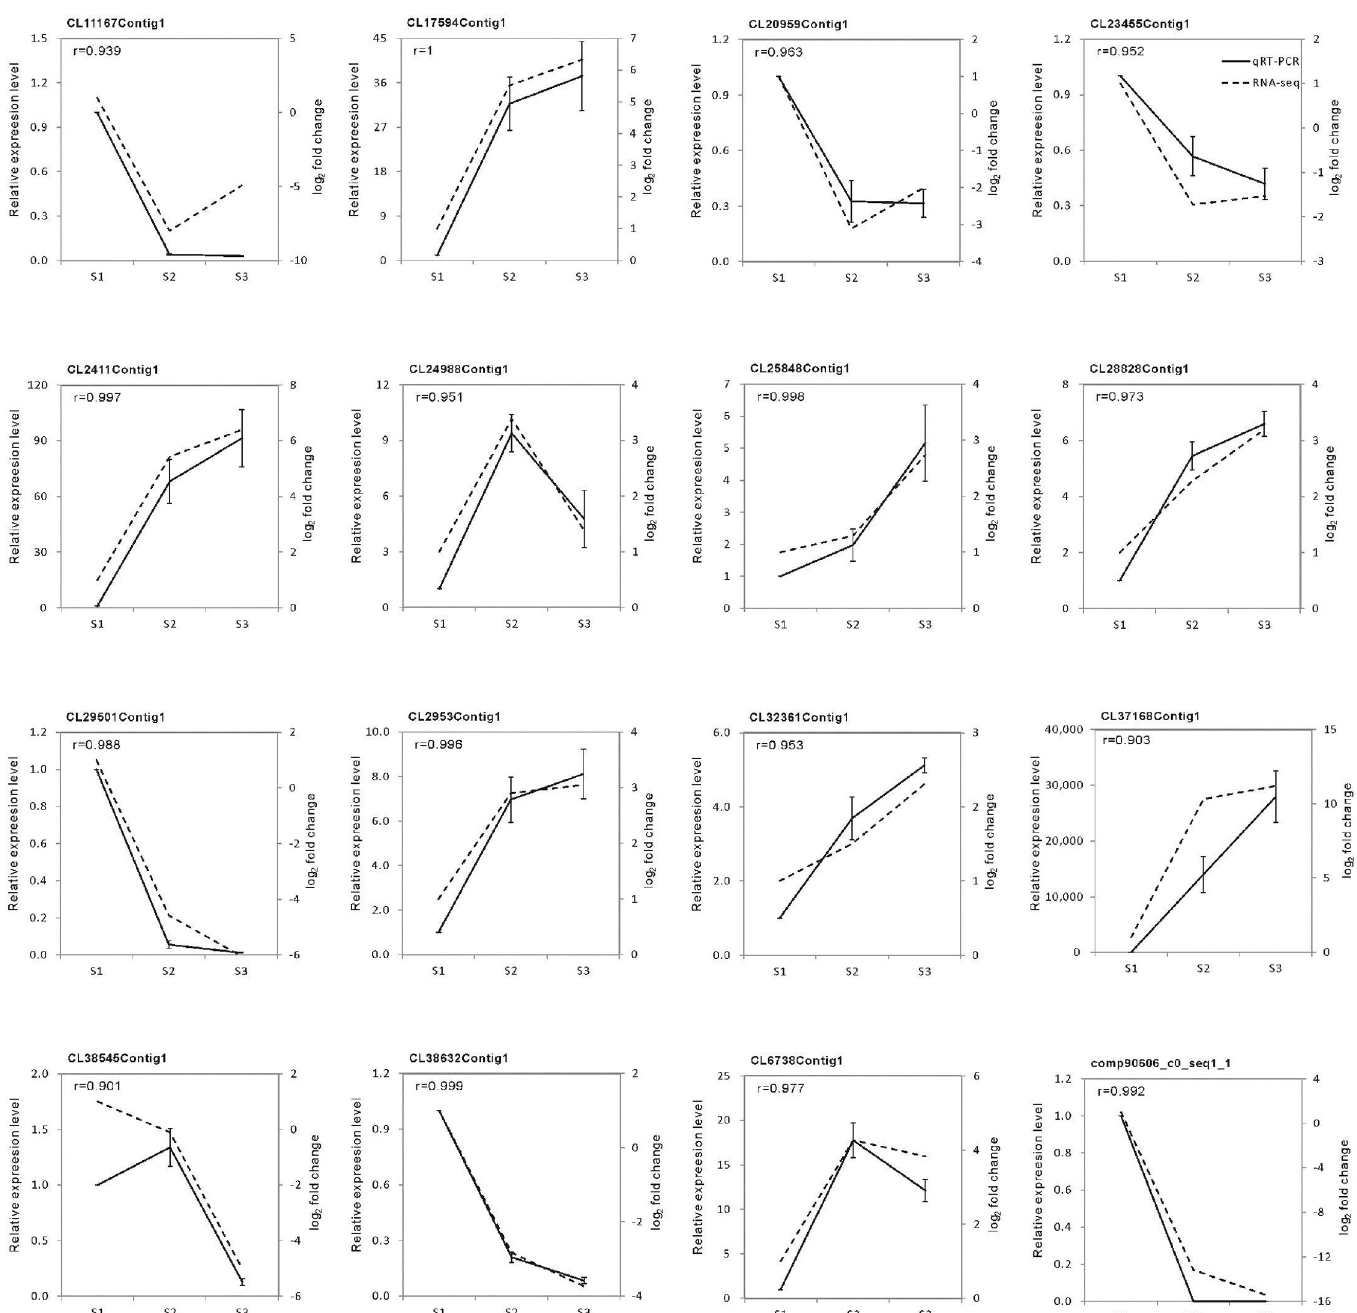
Fig 6. RT-qPCR validation. EF1a was used as the internal control. The error bars represent the SE of the RT-qPCR data ( n = 3). “r” represents the Pearson correlation coefficient. Pearson correlation between the RNA-Seq data and RT-qPCR data was calculated using the log 2 fold change and the relative expression level.